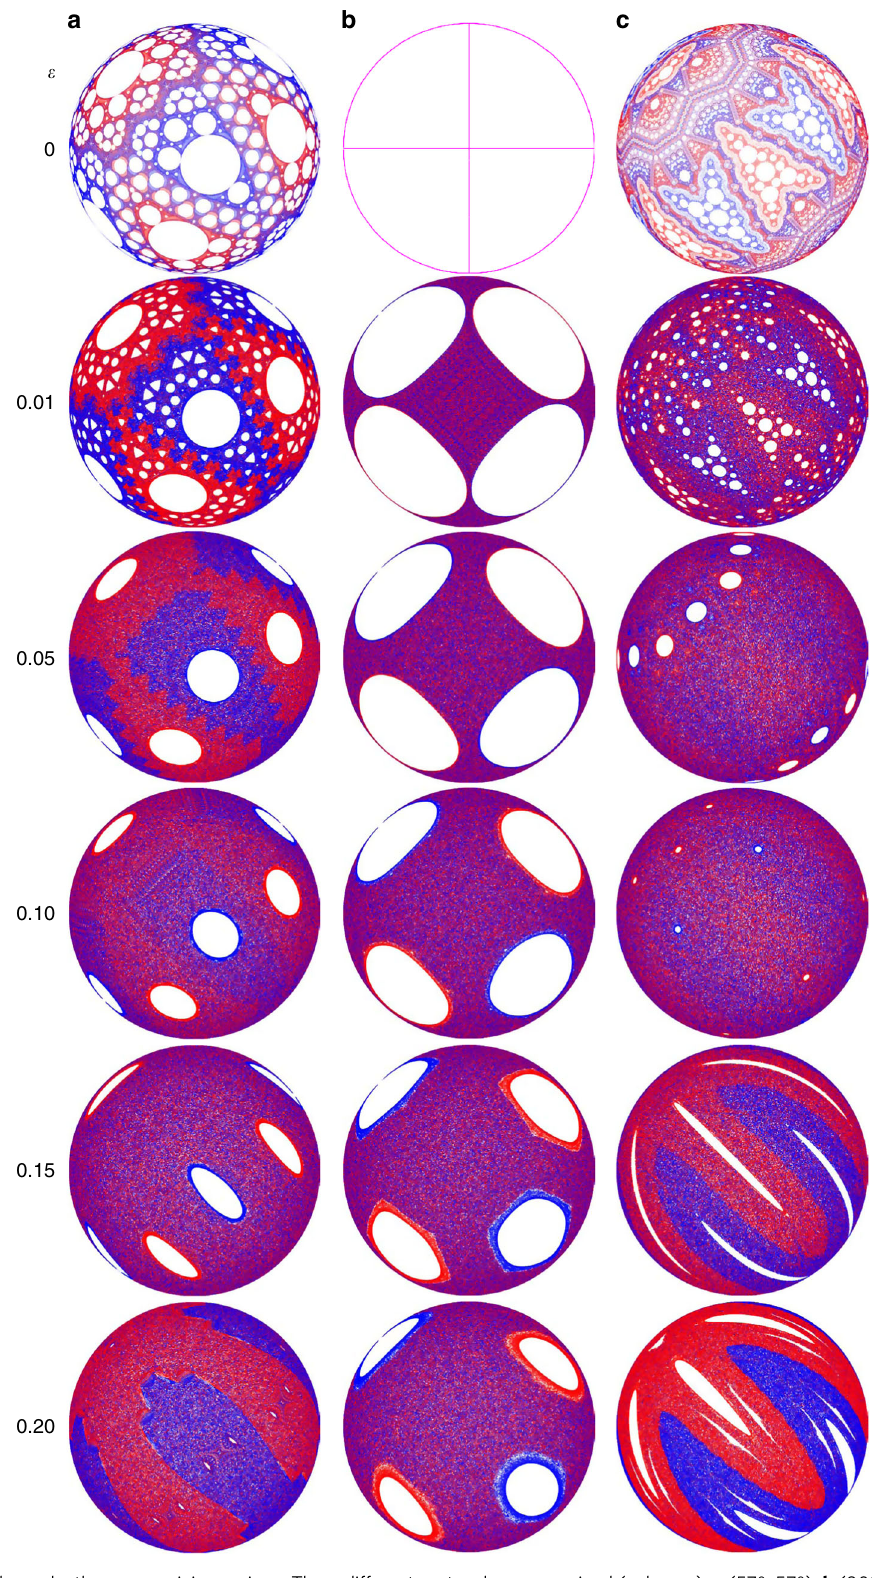
Fig. 7 Effect of fl owing layer depth on non-mixing regions. Three different protocols are examined (columns): a (57°, 57°), b (90°, 90°), and c (45°, 45°). With increasing fl owing layer depth, ϵ (rows), non-mixing regions formed by cutting-and-shuf fl ing ( ϵ = 0) shrink in a – c and disappear in a , c , while new non-mixing regions originating from stretching-and-folding in the fi nite depth fl owing layer appear and grow in c for ϵ ≥